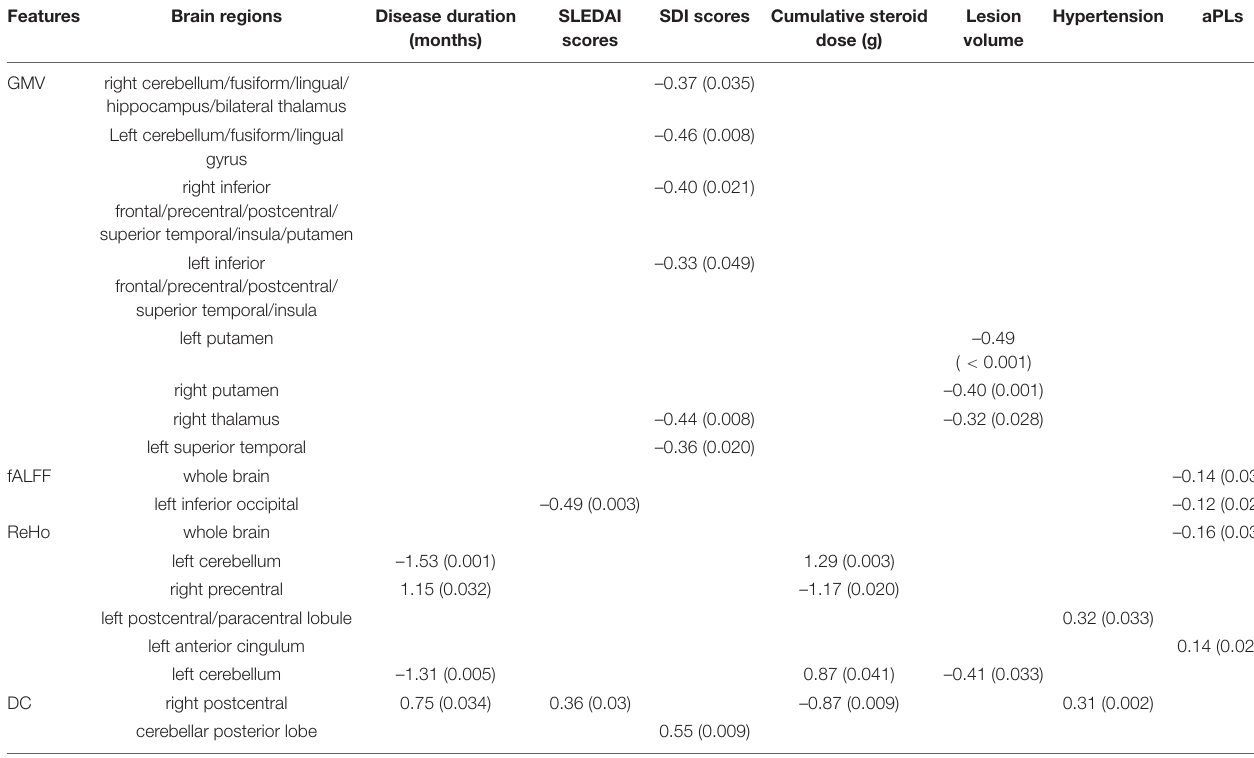
TABLE 4 | The clinical associations of MRI measurements with clinical variables using linear regression in SLE patients (including both NPSLE and non-NPSLE).